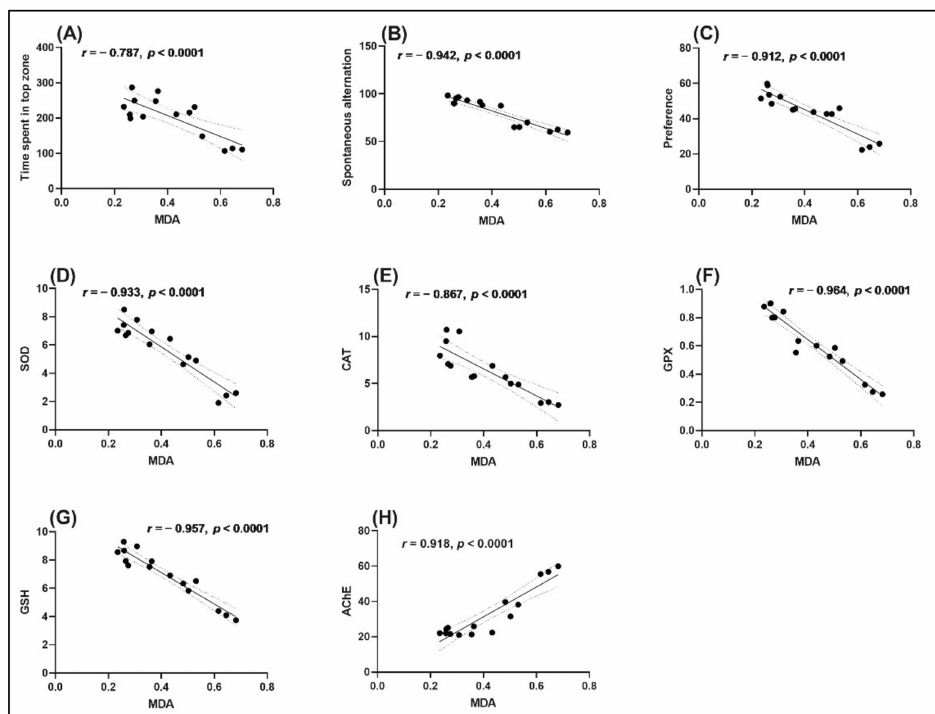
Figure 8. Correlation analyses between behavioral and biochemical parameters (Pearson’s correla- tion). ( A ). Time spent in top zone vs. MDA; ( B ). Spontaneous alternation vs. MDA; ( C ). Preference vs. MDA; ( D ). SOD vs. MDA; ( E ). CAT vs. MDA; ( F ). GPX vs. MDA; ( G ). GSH vs. MDA; ( H ). AChE vs. MDA. Data expressed are time in tope zone (s), spontaneous alternation %, preference %, SOD (U/mg protein), CAT ( µ mol H 2 O 2 consumed/min/mg protein), GPX (U/mg protein), GSH ( µ g GSH/ µ g protein), AChE (nmol/min/mg protein), and MDA (nmol/mg